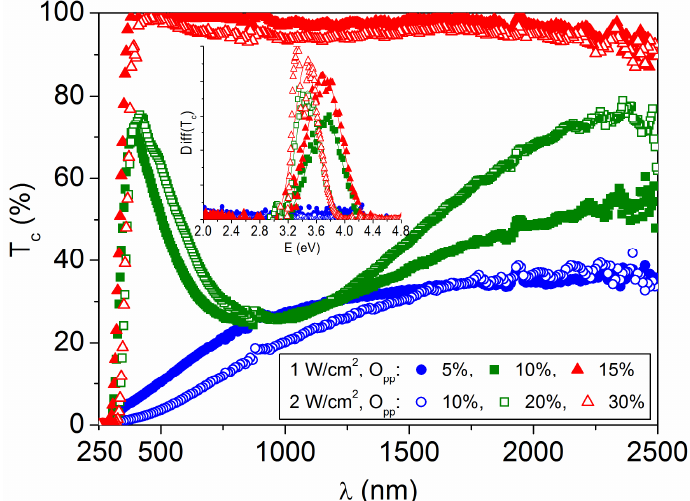
Figure 4. Optical transmittance as a function of the light wavelength for WO 3 − x films prepared at different sputtering powers and oxygen partial pressures. The inset shows differential of the transmittance curves as a function of the light energy (from the derivative dT c /dE).